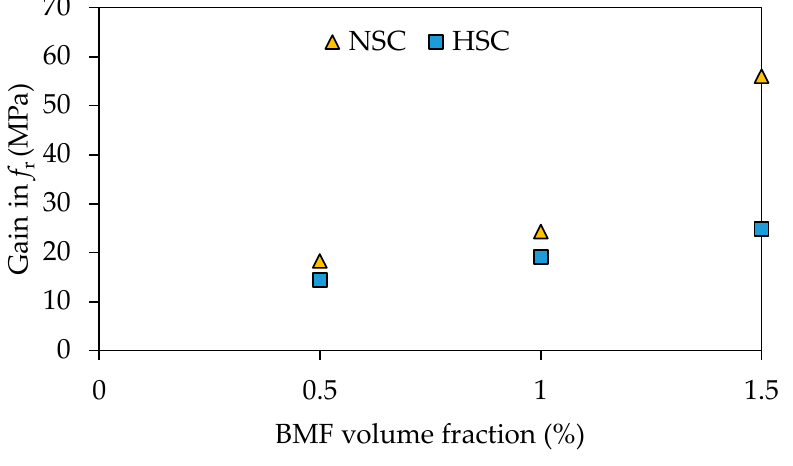
Figure 12. Flexural strength gain versus BMF volume fraction relationship.